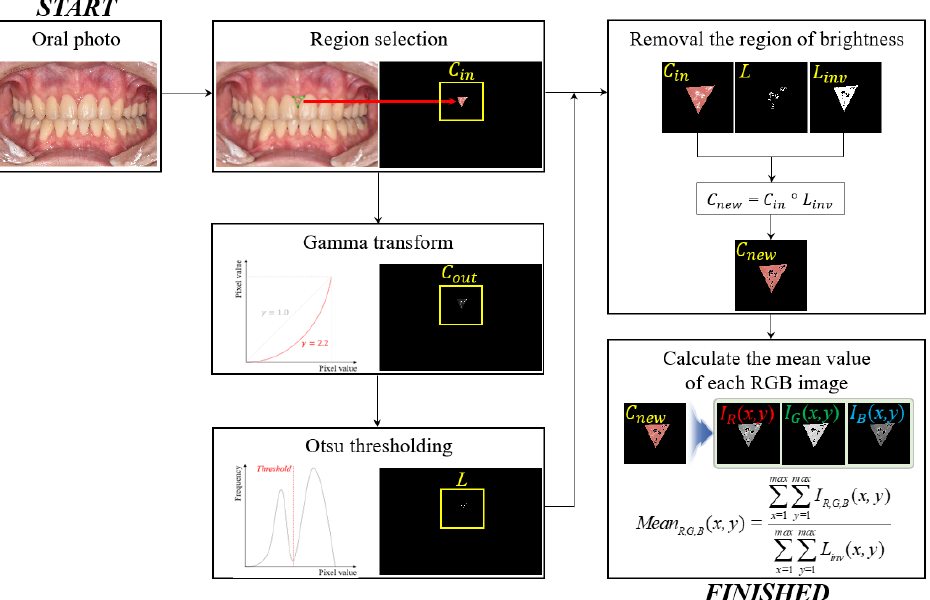
Figure 2. Simplified illustration of the proposed redness measurement framework using a standard oral photograph.